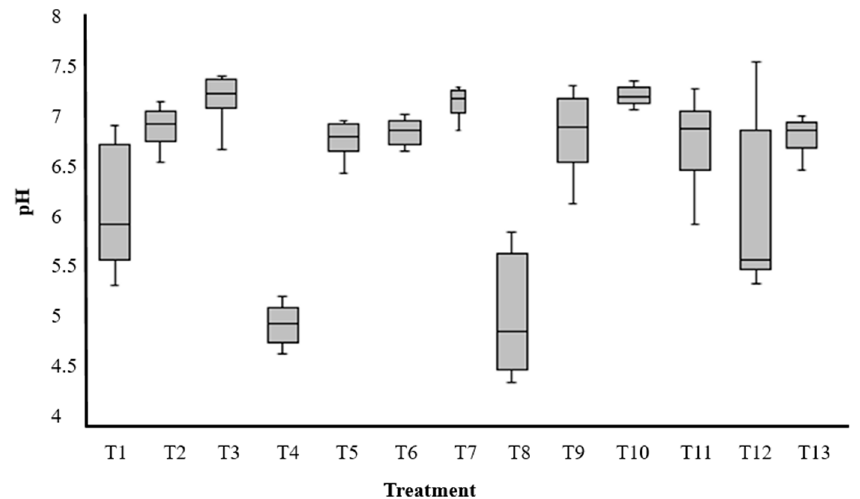
Figure 4. Boxplot graph of pH values daily collected from treatments 1 to 13 throughout 10 days on the definitive screening design experiment.